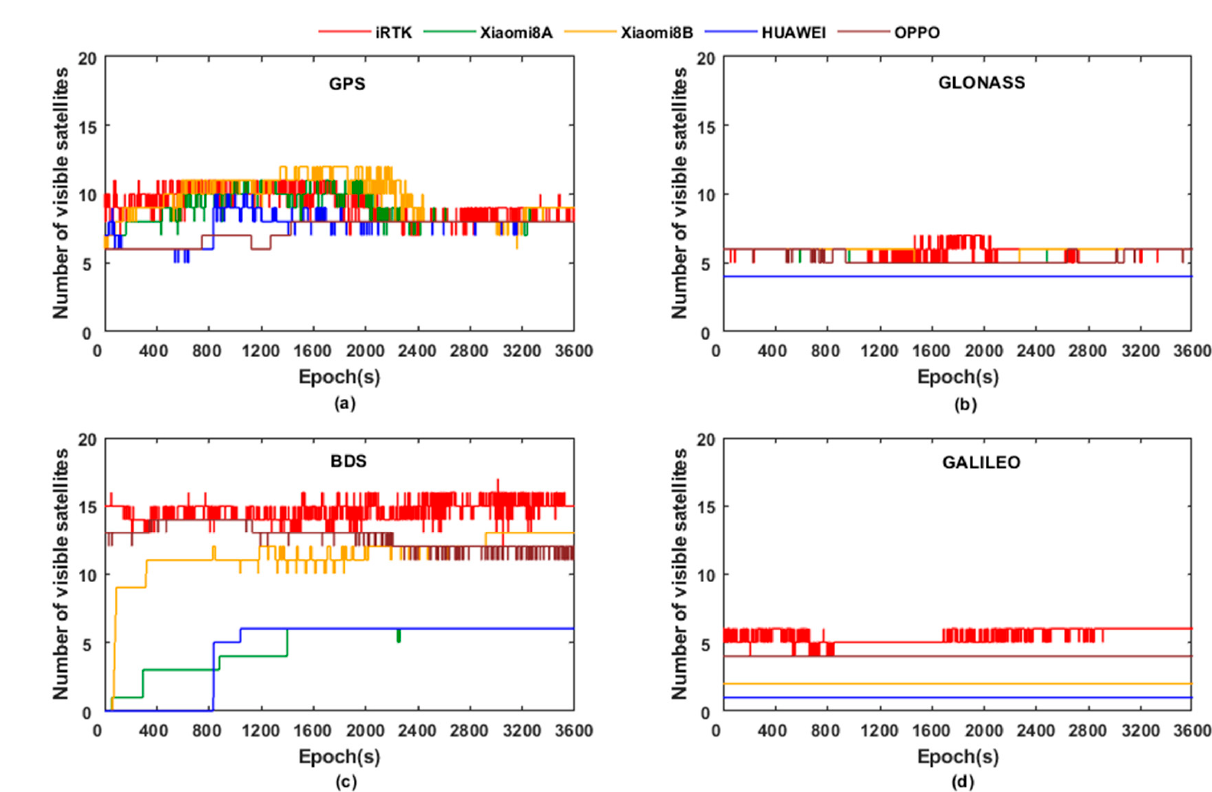
Figure 2. The number of visible satellites in each system observed by the experimental equipment. ( a ) The number of GPS observed by the experimental equipment; ( b ) The number of GLONASS observed by the experimental equipment; ( c ) The number of BDS observed by the experimental equipment; ( d ) The number of GALILEO observed by the experimental equipment.